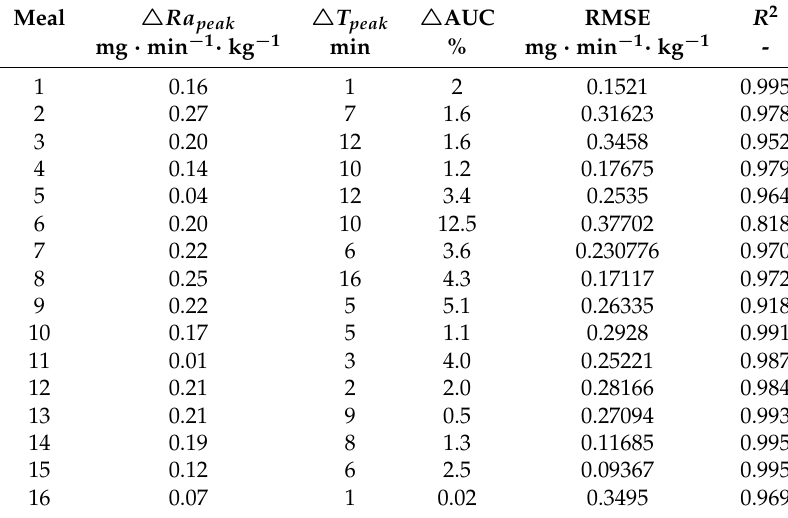
Table A3. Metrics to evaluate the R a model fitting to reference R a